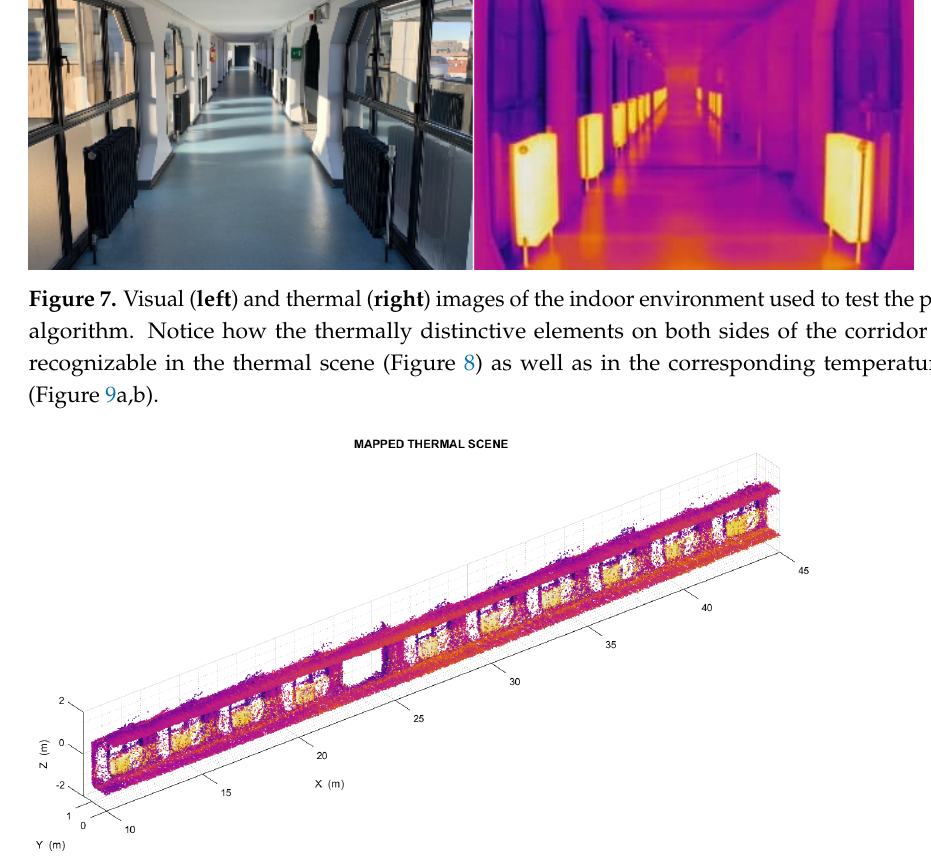
Figure 8. Left side of the thermal scene produced during the test in the indoor